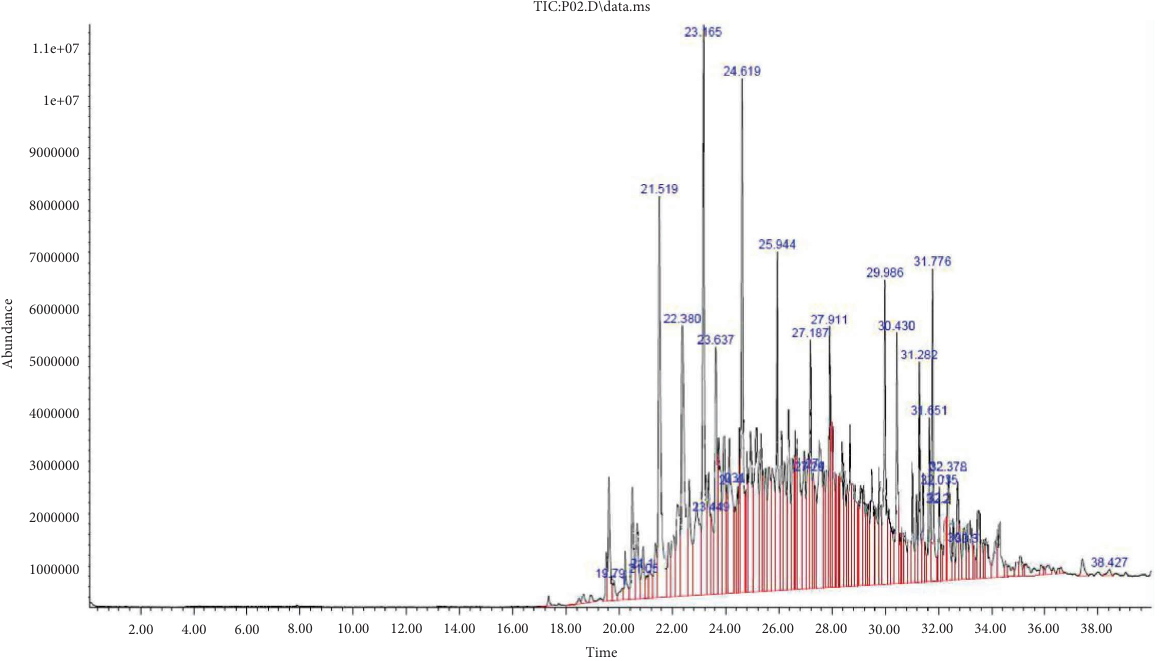
Figure 2: Mass spectra of the organic fraction of lead sludge.